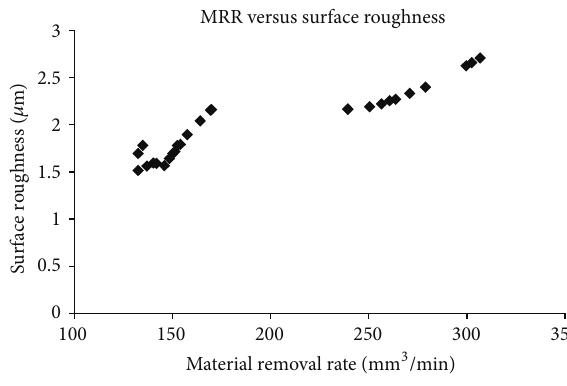
Figure 2: Optimal parameters of aqueous NaNO 3 solution from